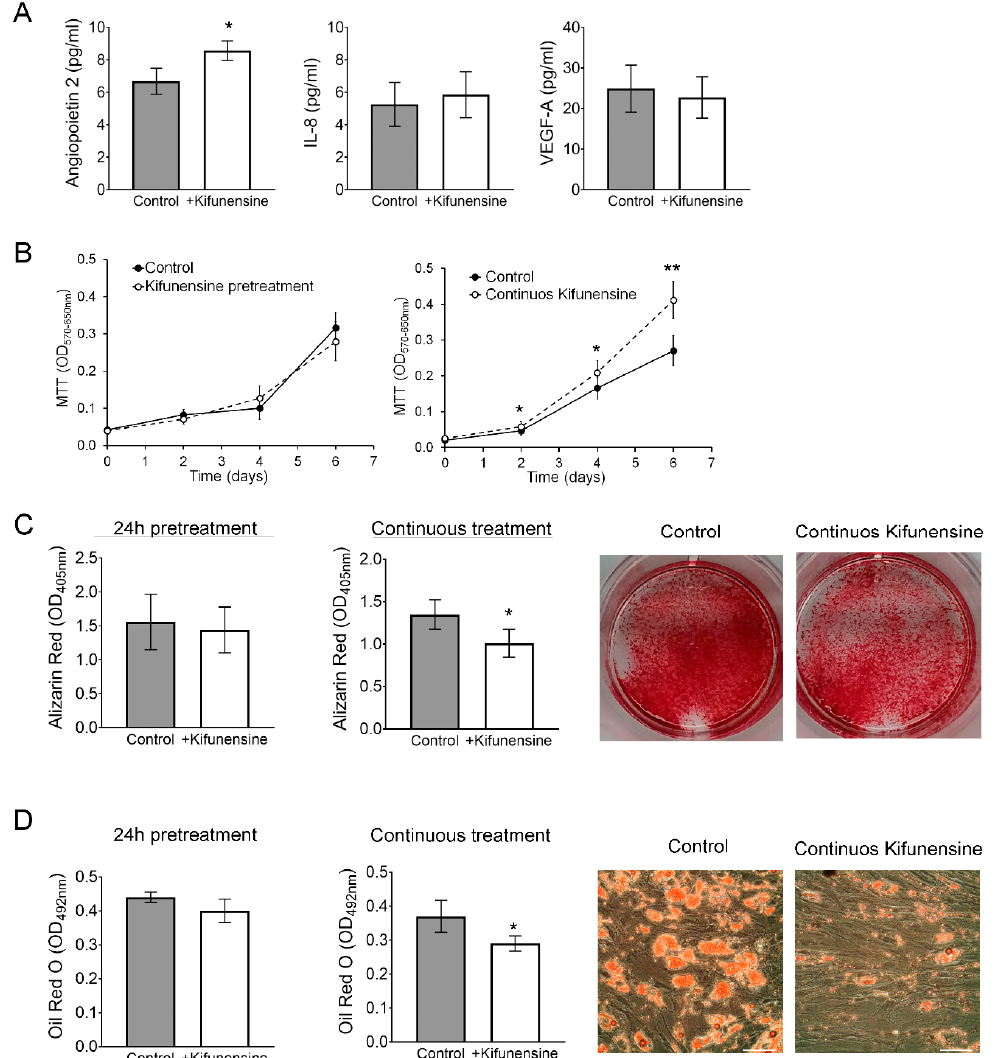
Figure 6. Continuous treatment with Kifunensine promotes migration, increases secretion of Angiopoietin 2 and inhibits both osteogenesis and adipogenesis. ( A ) ELISA to detect Angiopoietin 2, IL-8 and VEGF-A in the supernatant of MSCs treated for 24 h with or without Kifunensine ( n = 6). ( B ) MTT assay on MSCs treated with or without Kifunensine ( n = 6). ( C ) MSCs after 14 days in osteogenic media. Representative images of wells stained with Alizarin Red and quantification ( n = 7). ( D ) MSCs after 14 days in adipogenic media. Representative images of Oil Red O staining and quantification ( n = 5). * p < 0.05, ** p < 0.005. Scale bar = 100 µ